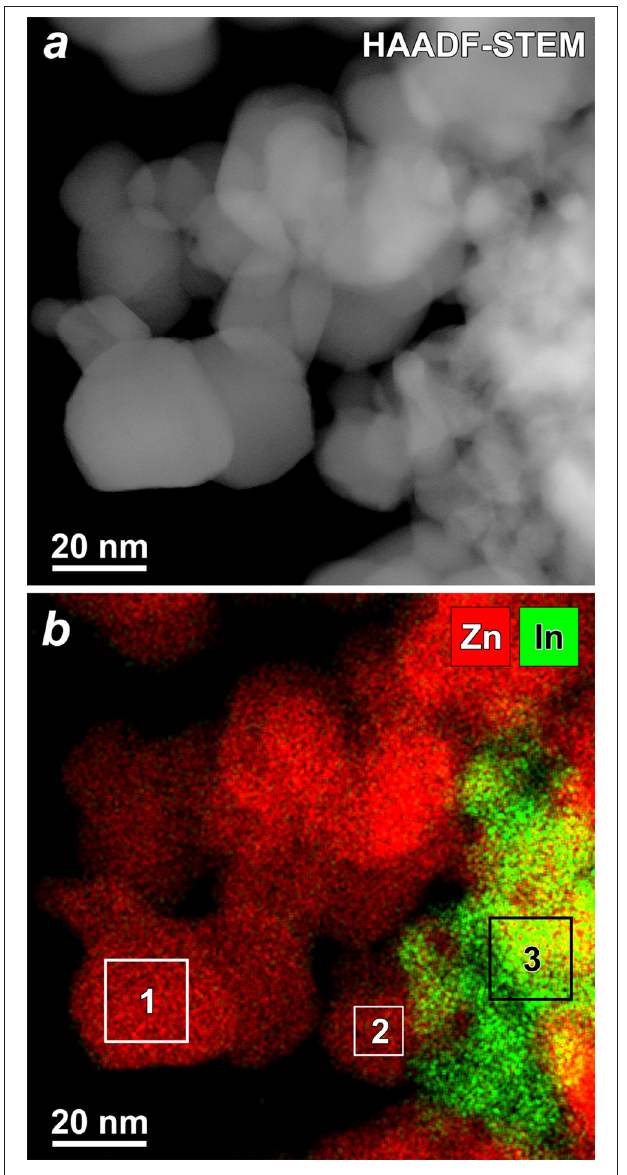
FIGURE 4 | (a) HAADF-STEM image of the ZnO(In, 1 at.%) sample and (b) complementary EDX map (red–Zn, green–In). EDX spectra from selected areas showed no In in areas 1 and 2, and presence of In in area 3 ( Figure S3 ).